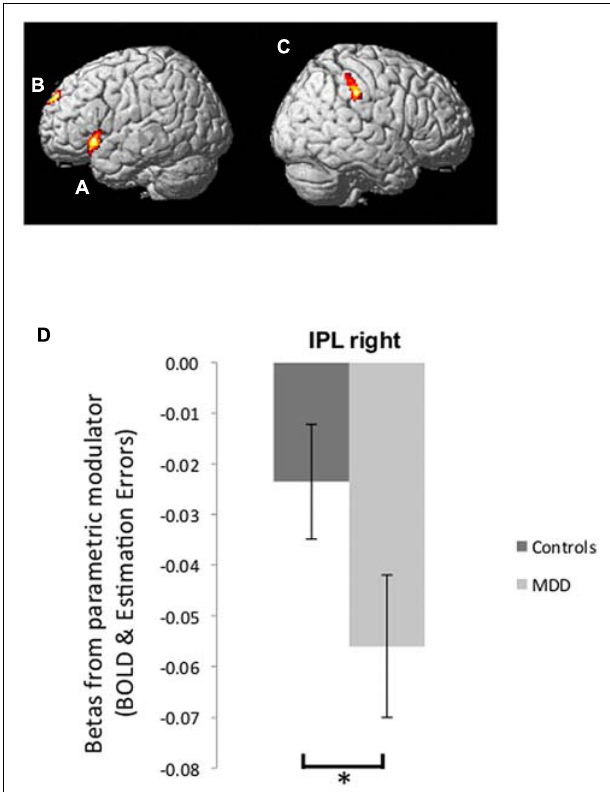
FIGURE 4 | Brain activity tracking estimation errors. (A,B) Regions in which BOLD signal tracked participants’ estimation errors on a trial-by-trial basis across both groups in response to good news regarding future likelihoods included the left IFG (A) and bilateral SFG (B) ( p < 0.05, FWE cluster level corrected). (C) BOLD signal tracking participants’ estimation errors in response to bad news was found in the right IPL ( p < 0.05, FWE cluster level corrected). (D) Parameter estimates of the parametric regressors from peak voxels in the right IPL showed a stronger inverse correlation between BOLD activity and bad news errors in depressed individuals relative to healthy individuals. Error bars represent SEM * p < 0.05, two-tailed independent samples t